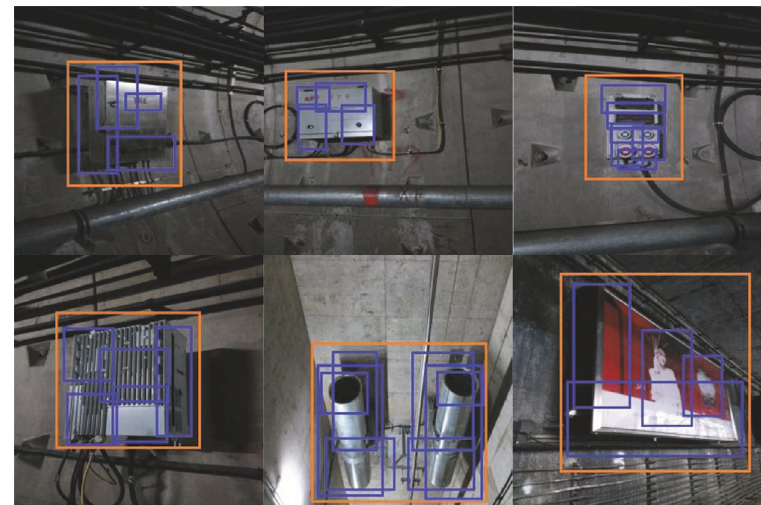
Figure 9: A few results by DPM.